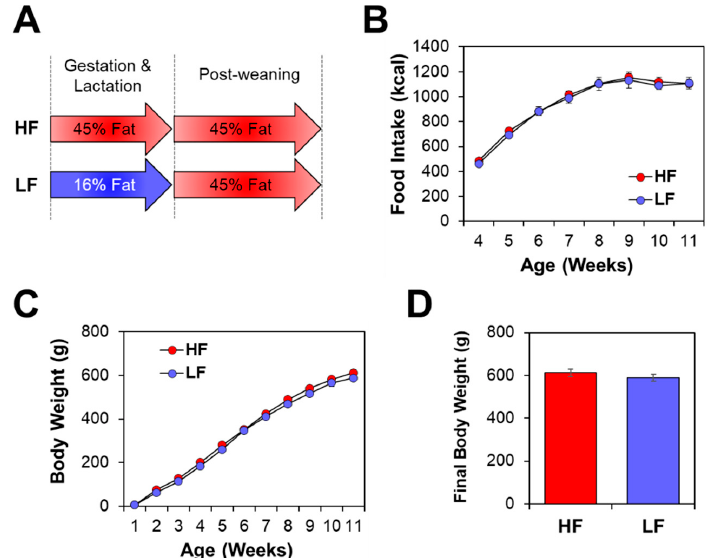
Figure 1. Maternal diet did not impact postnatal phenotype when followed by a high-fat (HF) diet. ( A ) Male Sprague-Dawley rats were given either a HF or low-fat (LF) diet during gestation and lactation (seven weeks). Both groups were given a HF diet after weaning (nine weeks; n = 10/group). ( B ) Caloric intake after weaning did not differ between the two groups. ( C ) Postnatal, and ( D ) final, body weight did not differ between groups.